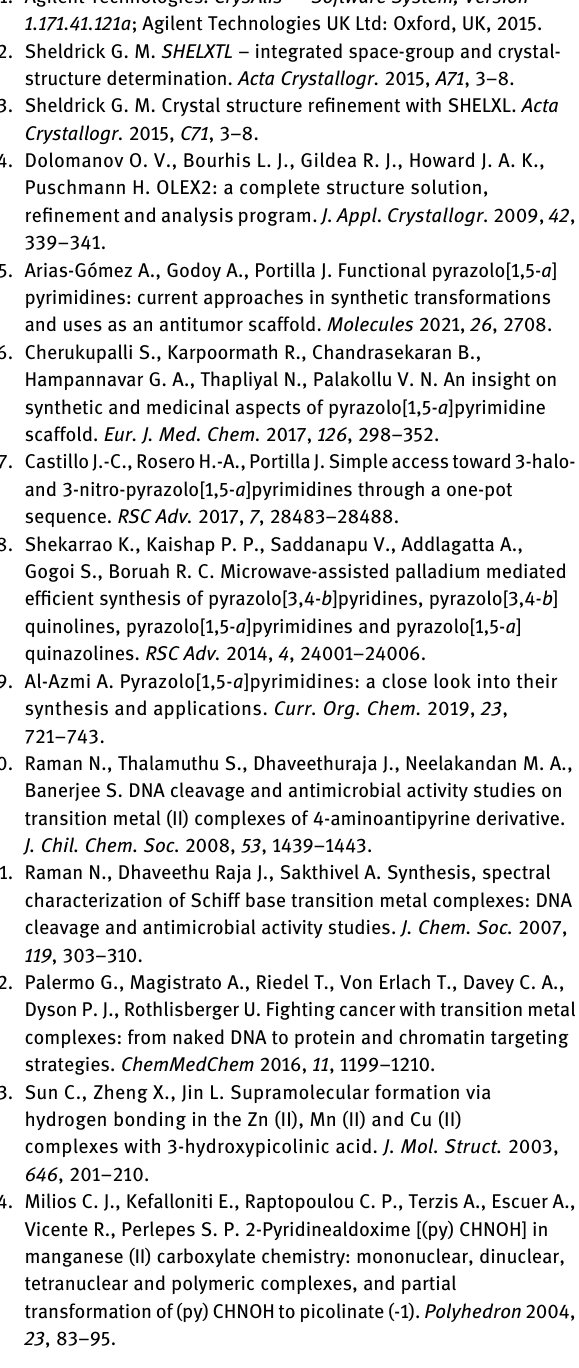
Table  : Fractional atomic coordinates and isotropic or equivalent isotropic displacement parameters (Å 